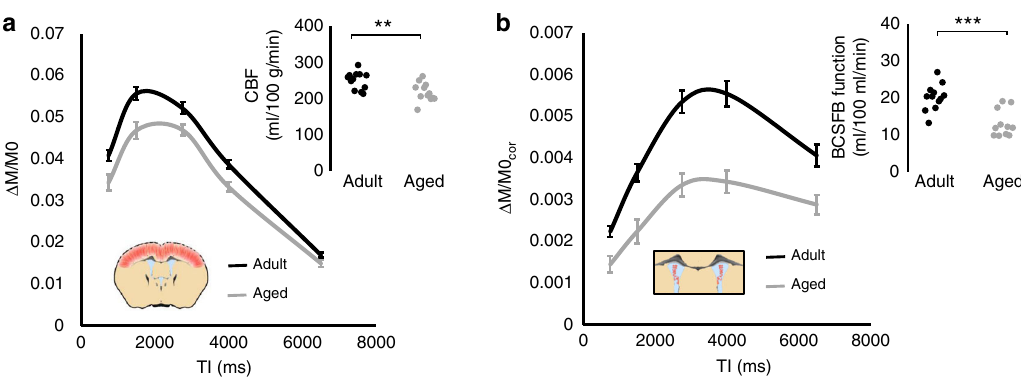
Fig. 2 Non-invasive MRI of BCSFB function: application to the ageing brain. a The normalised cortical ASL signal as a function of TI for the adult (black) and aged (grey) cohort. Error bars represent SEM across the group; inset: the estimated cortical blood fl ow for each individual subject. n = 12/11 biological independent animals examined over 12/11 independent experiments for each group, respectively. ** p = 0.0021 from a one-tailed t -test. b The normalised lateral ventricle BCSFB-ASL signal as a function of TI for the aged (grey) and adult (black) cohort; error bars represent SEM across the group. Inset: the estimated rate of BCSFB-medicated blood water delivery to the lateral ventricles for each individual subject. n = 12 and 11 biological independent animals examined over 12 and 11 independent experiments for the adult and aged group, respectively. *** p = 0.00006 from a one-tailed t